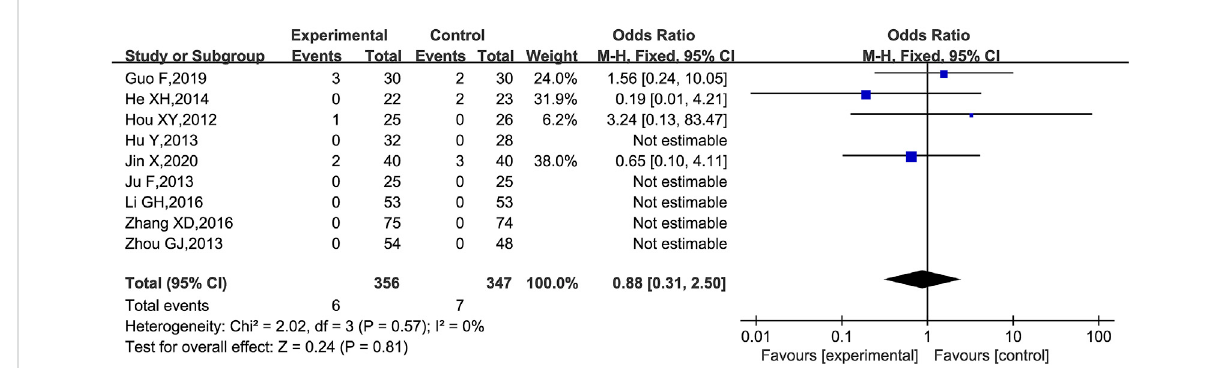
FIGURE 11 Forest plot of adverse events for KLXC + Western medicine vs. Western medicine alone.